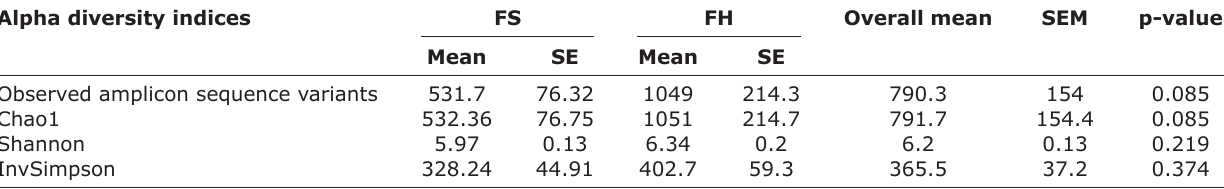
Table-4: Alpha diversity metrics of microbial communities in the rumen of camels fed different forages. Alpha diversity indices FS